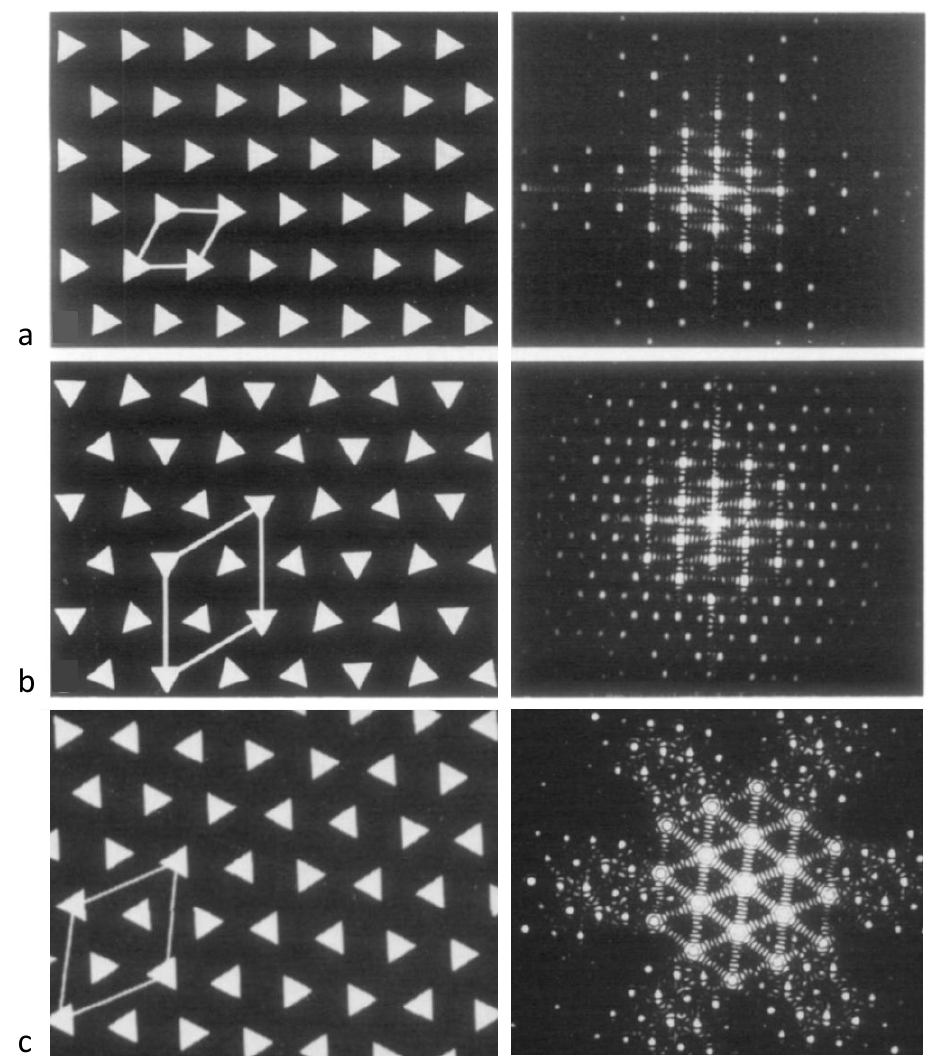
Figure 3. Images of model bare-regions comprising (left) triangular profile filaments on a hexagonal lattice and (right) their diffraction patterns. ( a ) Single orientation filaments as seen in bony fish muscle. ( b ) Perfect superlattice formed by relative rotations of 0, 40° and 80° between adjacent filaments. ( c ) Bare-region model for frog muscle with only two orientations, 0 and 180° (or 60°) apart as observed in electron micrographs and constructed using the no-three-alike rules. The randomness in ( c ) leads to noise in the diffraction pattern in the right panel compared with the ordered noise-free patterns in ( a ) and ( b ). Adapted from [18], with permission from